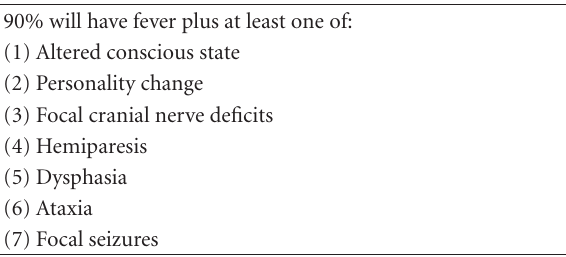
Table 1: Clinical Presentation of HSV